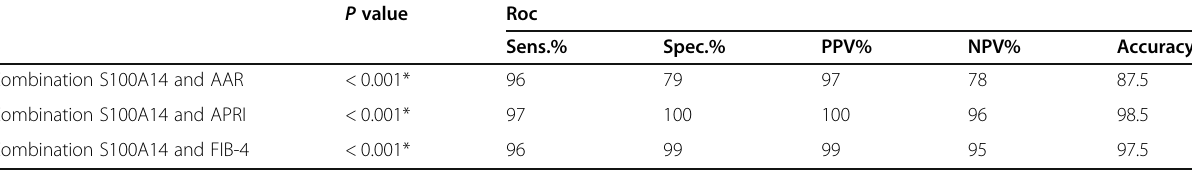
Table 6 The combination of S100A14 and AAR, APRI, and FIB-4 P value